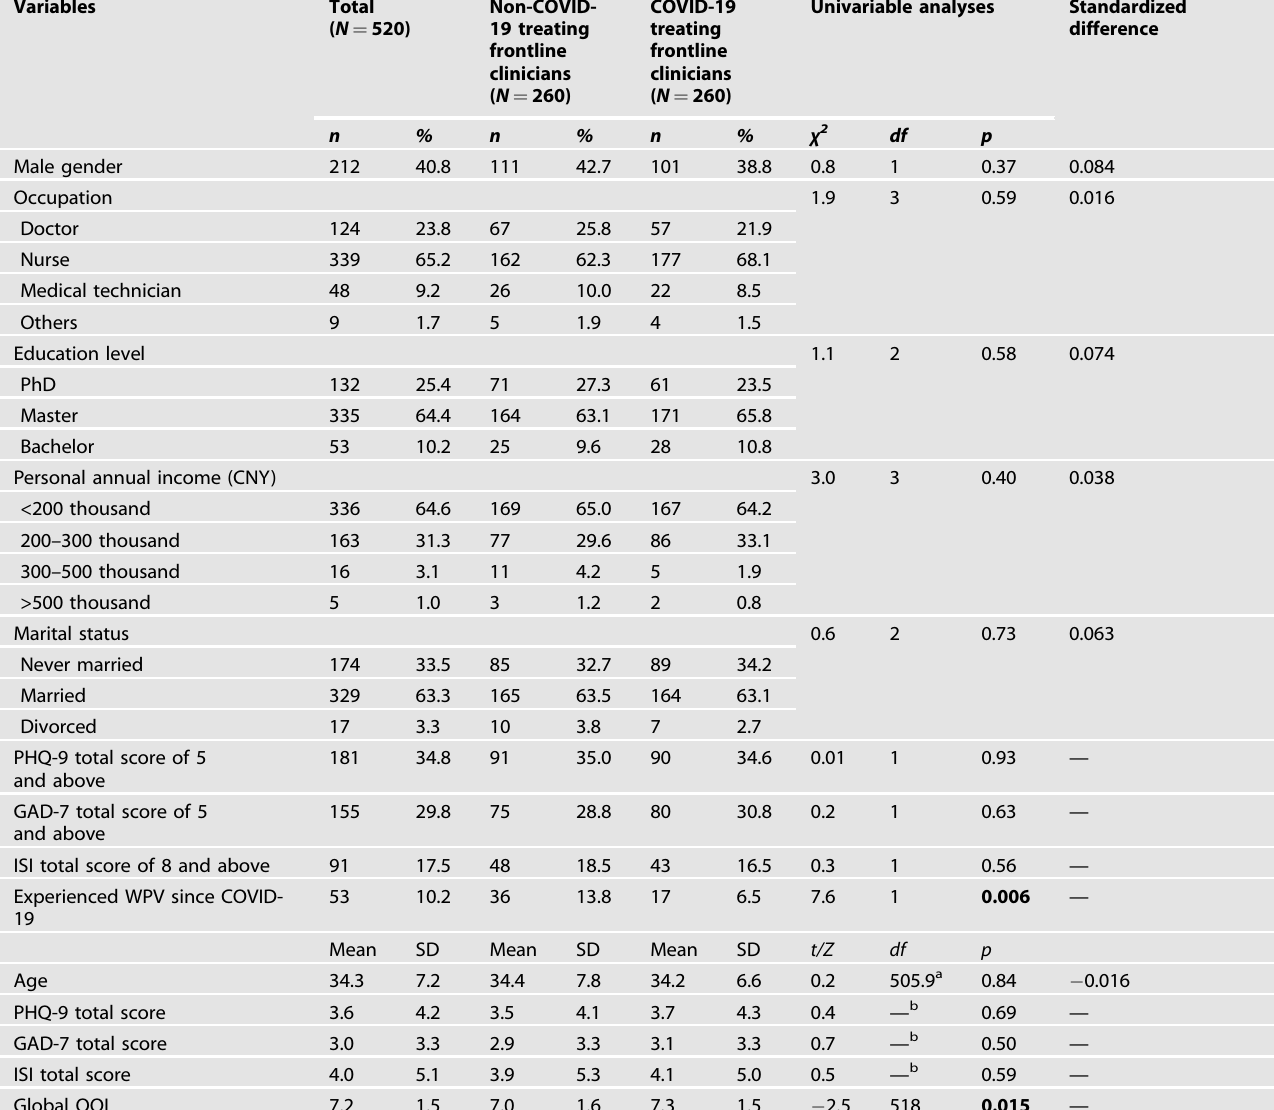
Table 1. Demographic and clinical characteristics of the matched sample ( N =